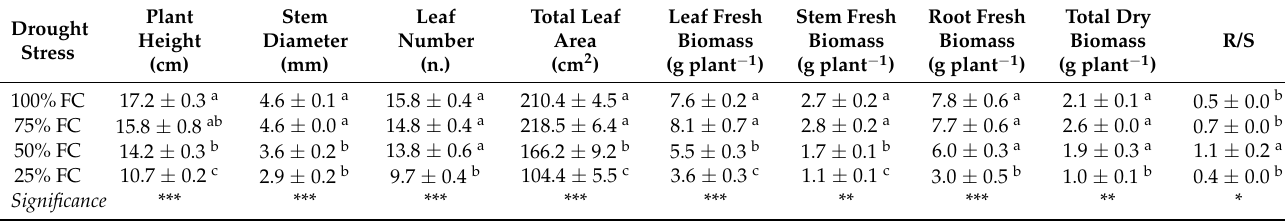
Table 1. Effects of irrigation treatments on plant height (cm), stem diameter (mm), leaf number (n.), total leaf area (cm 2 ), leaf, stem, root fresh weight (g plant − 1 ), total dry biomass (g plant − 1 ), and root/shoot ratio (R/S) of potted zinnia plants at the end of the experimental period. Plants were irrigated every day. Four treatments were performed: irrigated at 100% (100% field capacity, FC); light deficit irrigation (75% FC), irrigated at 75% from the 100% FC treatment; medium deficit irrigation (50% FC), irrigated at 50% from the 100% FC treatment and severe deficit irrigation (25% FC), and irrigated at 25% from the 100% FC